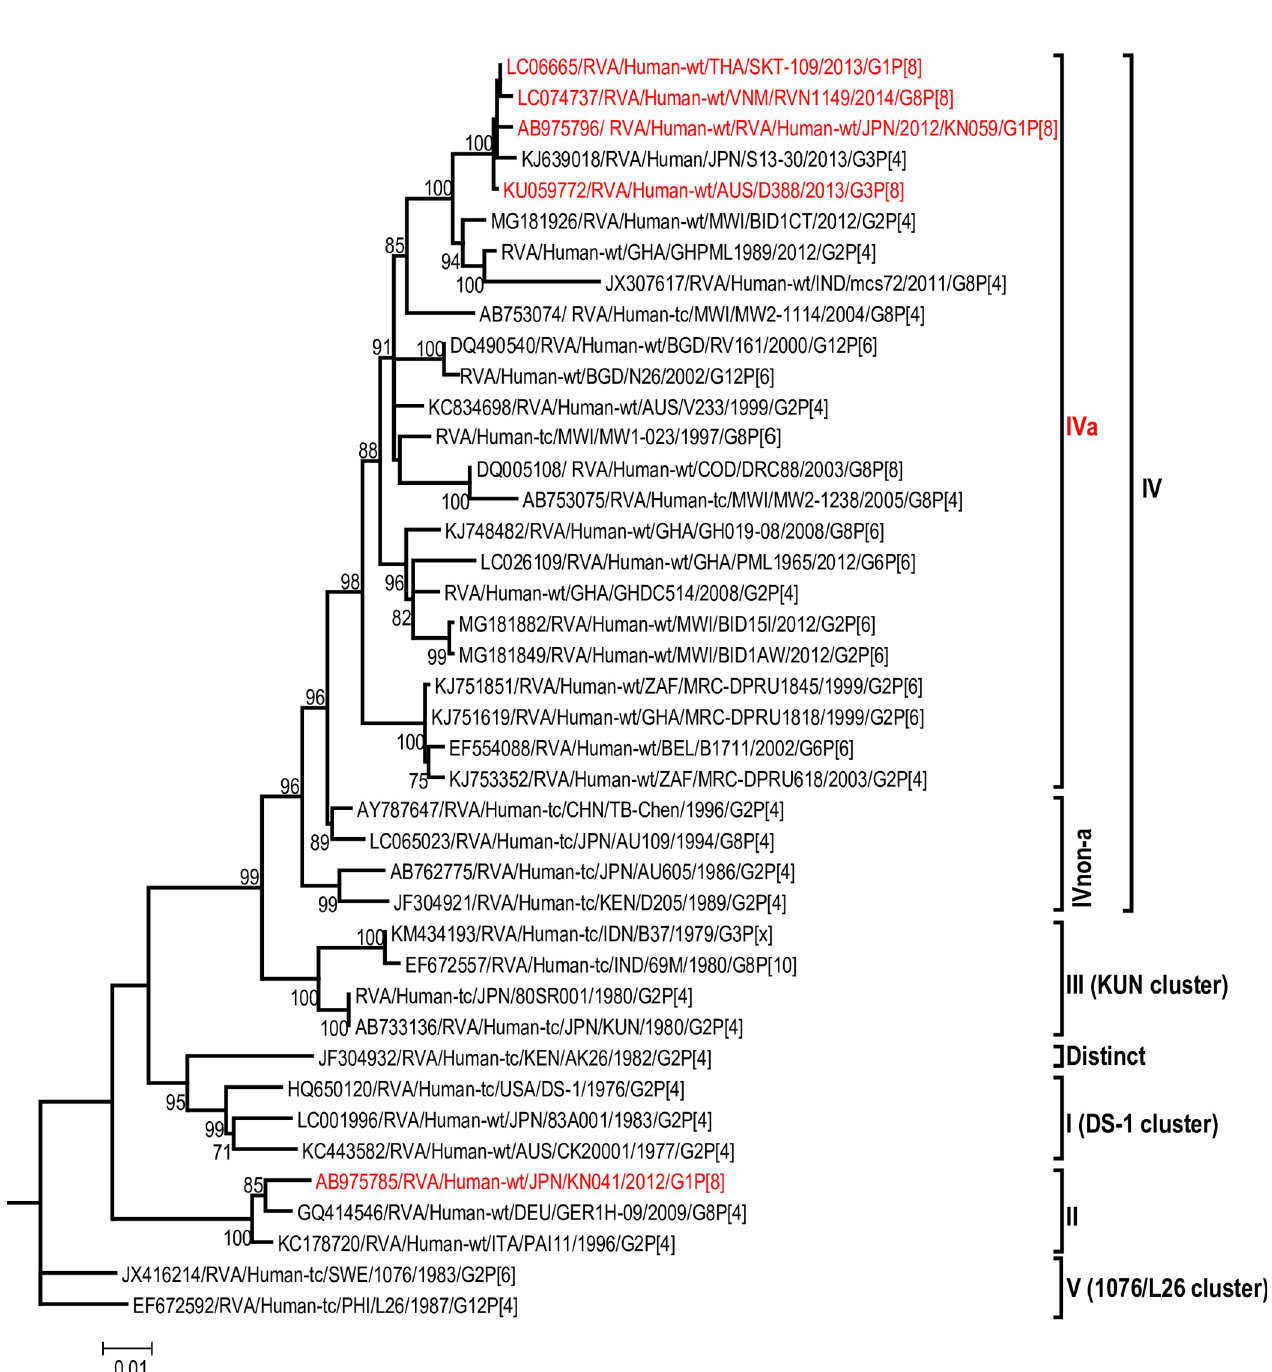
Fig 7. Reference phylogenetic lineage designation for the NSP1-A2 genotype of RVA strains. Phylogenetic tree was constructed using the maximum likelihood method with 1000 bootstrap replicate trials. The tree was rooted using the NSP1-A1 gene of the genotype 1 prototype strain Wa. Representative unusual emerging reassortant strains whose lineage constellations were determined in this study using the newly established phylogenetic framework are indicated in red font. Scale bar at the bottom of the tree represents genetic distance expressed as nucleotide substitutions/site.